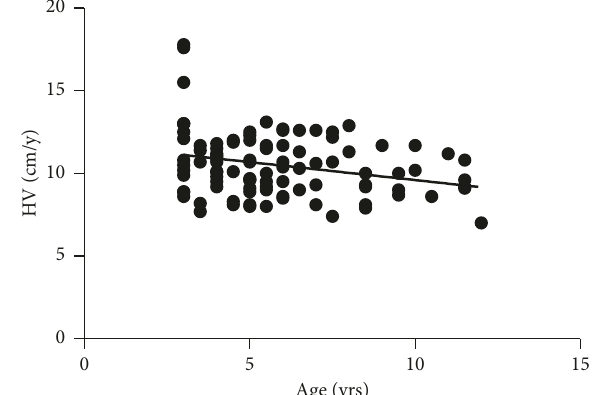
Figure 2: Relationship of 12-month HV to age at initiation of treatment in patients with GHD ( r �− 0.22, p � 0 .